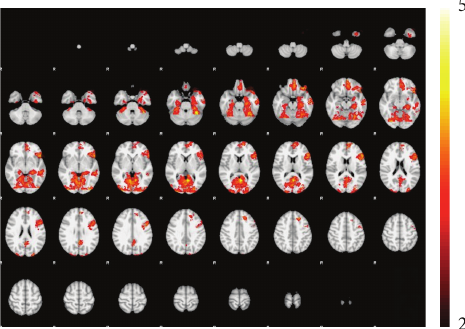
Figure 1: BOLD-fMRI activation during incidental memory encod- ing (whole-brain analysis, 𝑍 > 2.3 , FWE corrected) in individuals without diabetes.